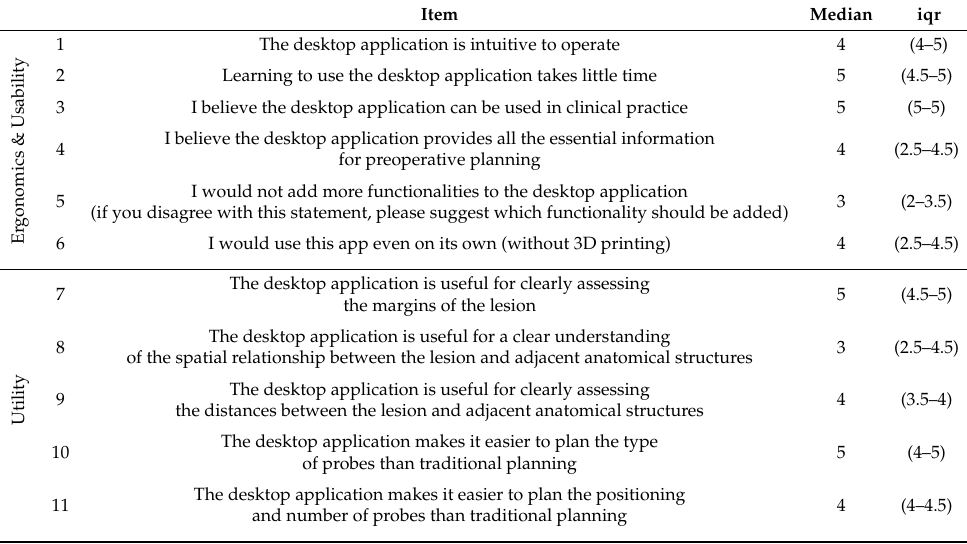
Table 4. Five point Likert questionnaire results for the Feedback on the Virtual Plan (from 1 = strongly disagree, to 5 = strongly agree). The central tendency of responses is presented by the median, with the dispersion presented by the interquartile range